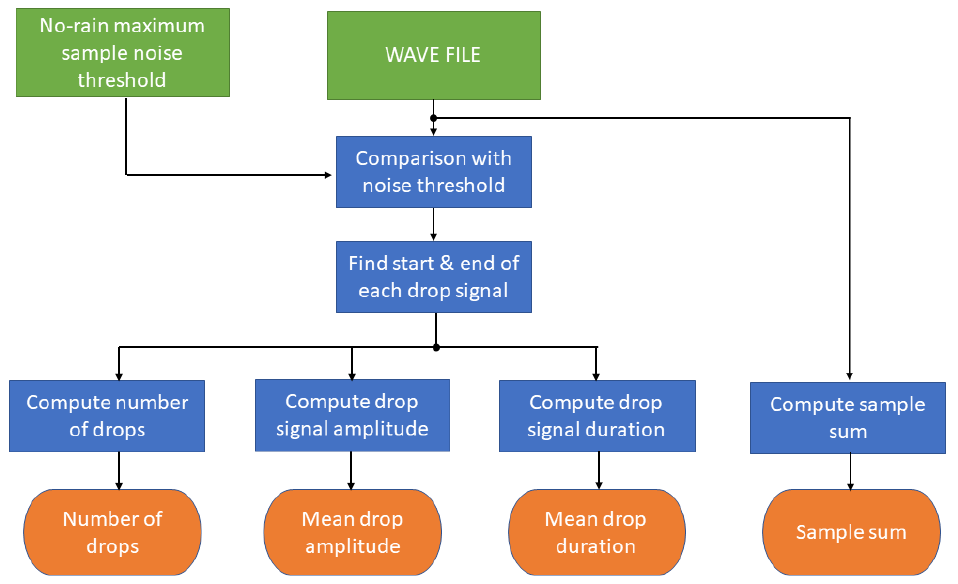
Figure 3. Block diagram of the processing for each 55 s wave file (see text for description of the